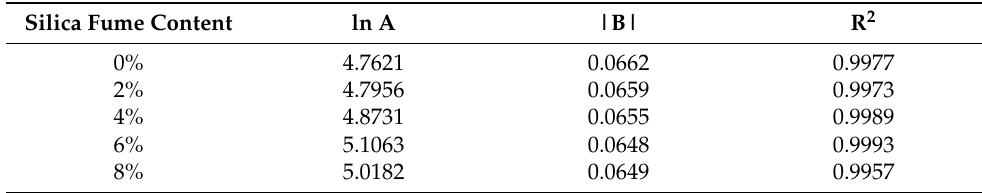
Table 5. Regression and correlation coefficients of silica fume/ styrene-butadiene-styrene composite- modified asphalt before